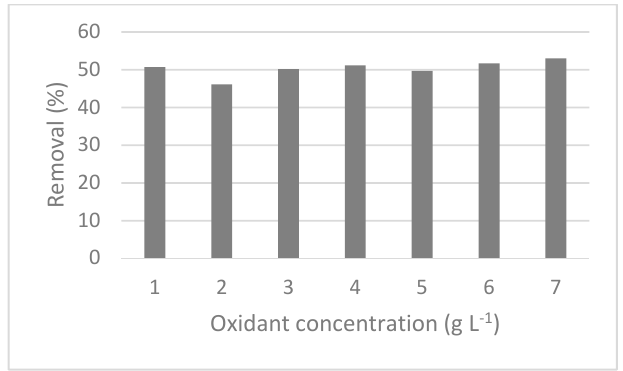
Figure 2. Effect of hydrogen peroxide oxidation on the removal of total phosphorus.